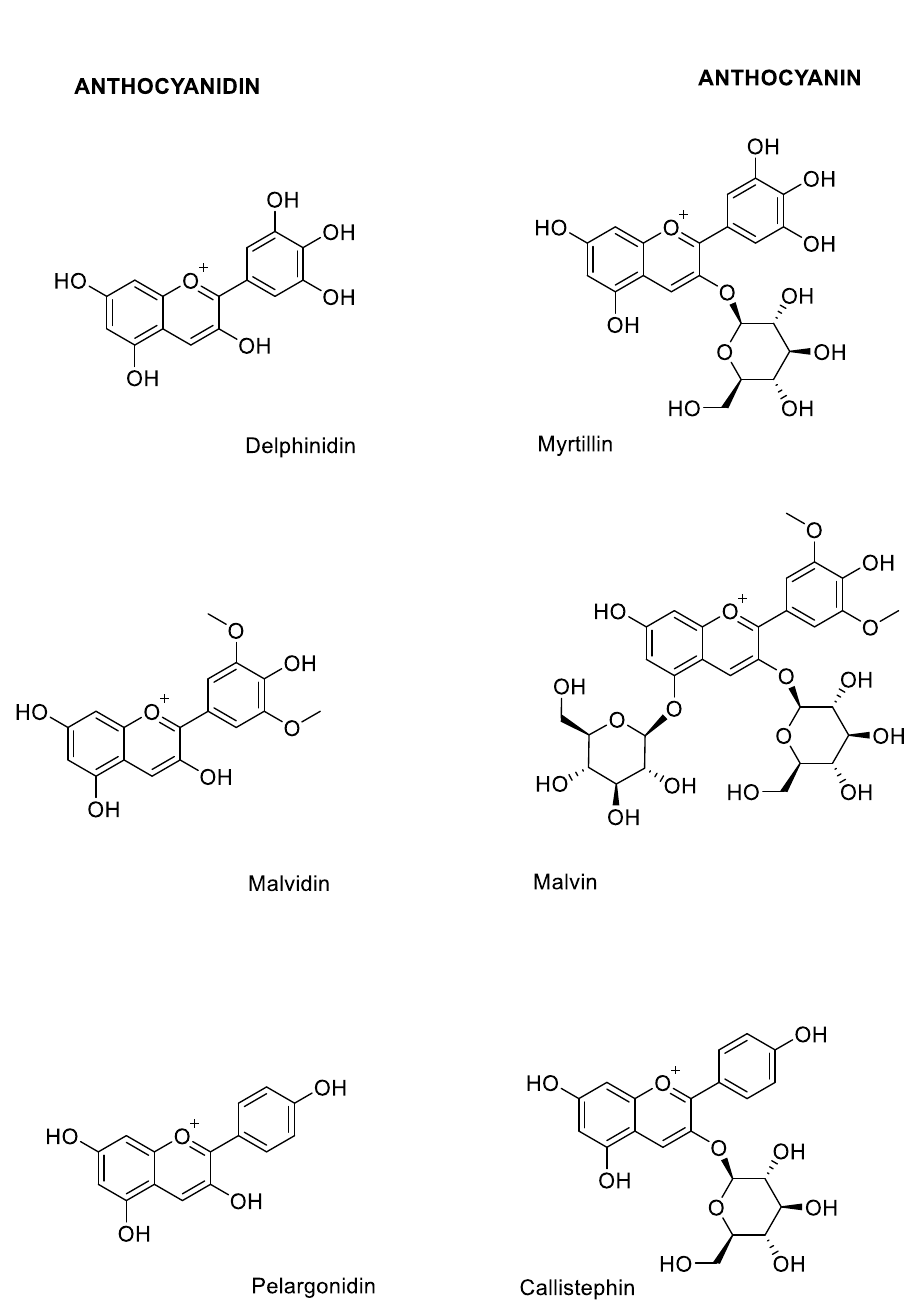
Figure 3. Chemical structure of some naturally occurring anthocyanidins (left) and corresponding mono- or di-glycosylated anthocyanins (right).